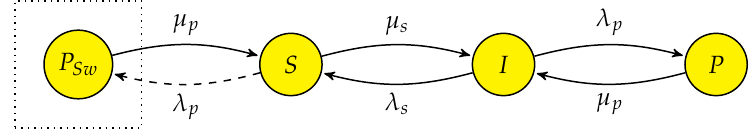
Figure 5. State Transition Diagram of CTMC PN-UC, “- - - >” indicates spectrum handoff